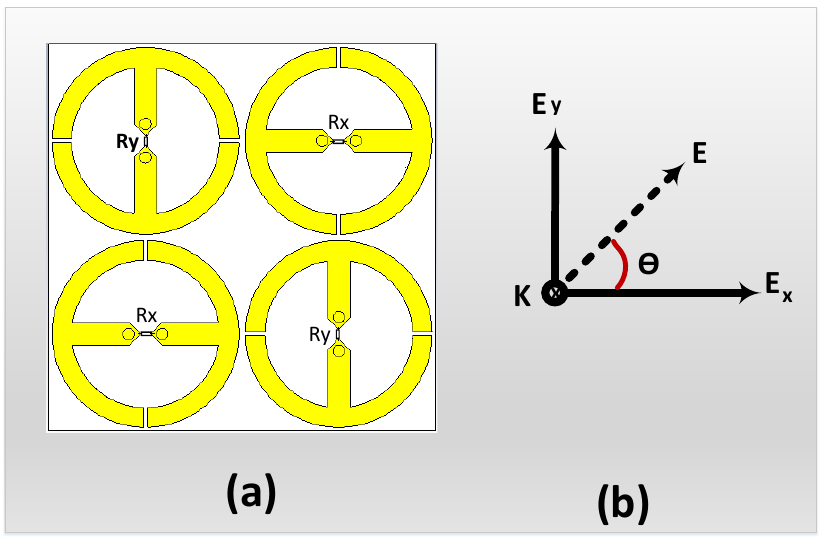
Figure 7. Geometry of the introduced supercell: ( a ) top loop layer and ( b ) view of the multiple polarizations at different angles of the incident